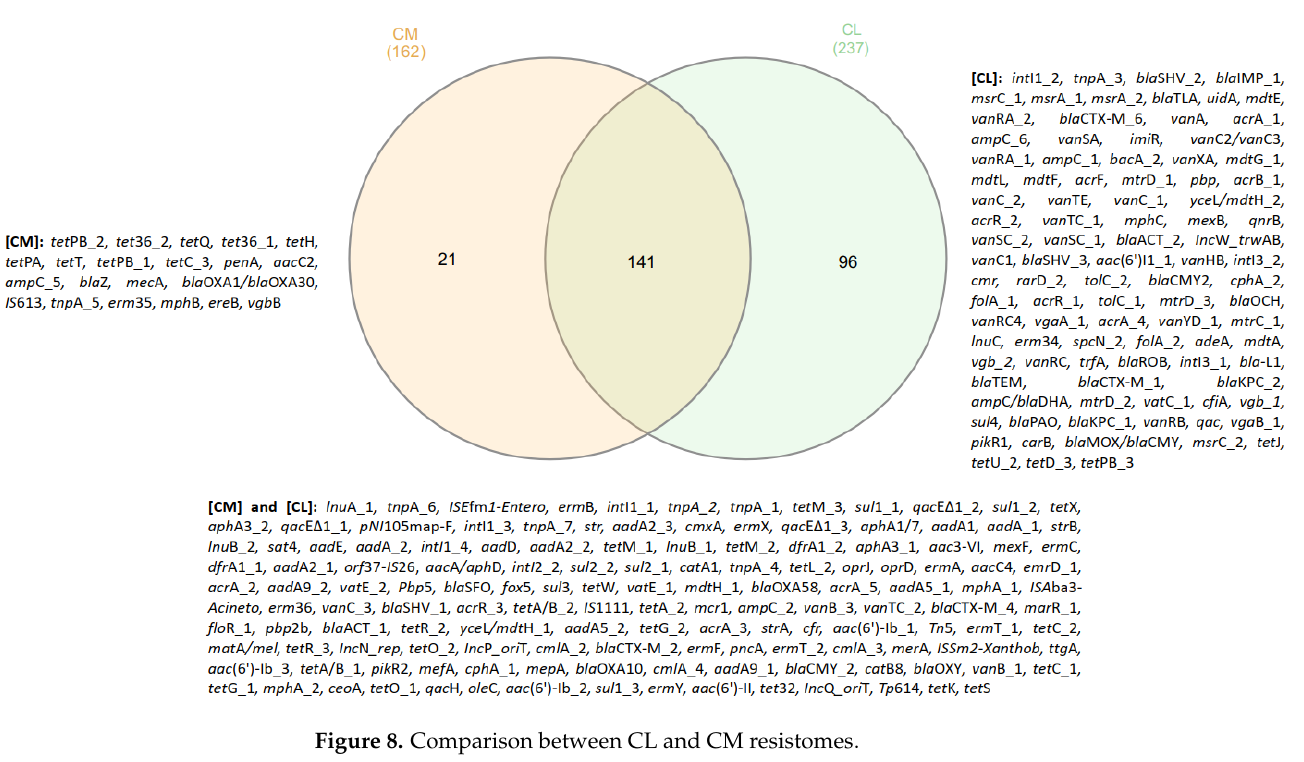
Figure 8. Comparison between CL and CM Figure 8 . Comparison between CL and CM resistomes.